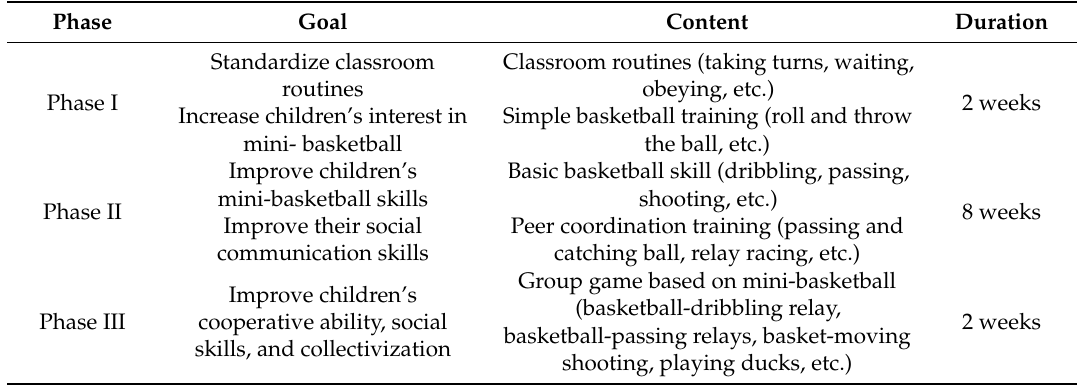
Table 2. Mini-basketball training program